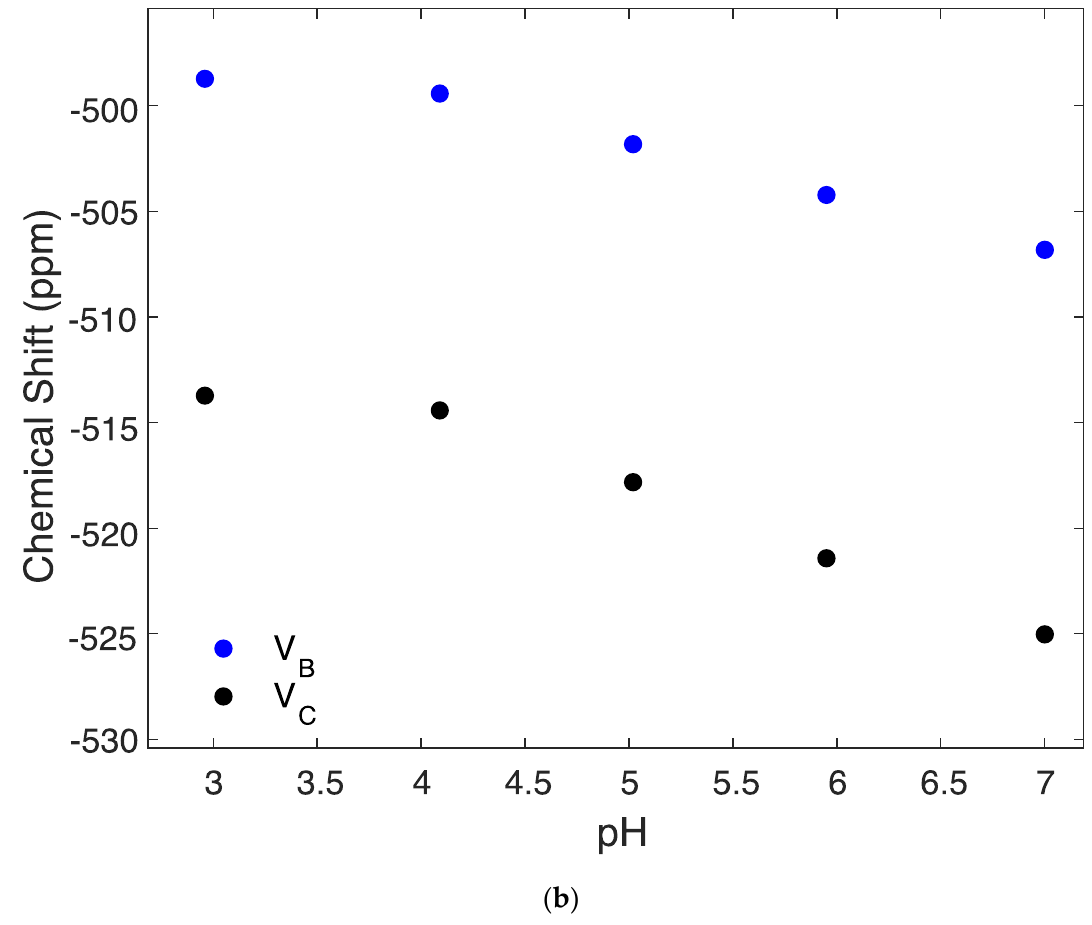
Figure 4. The 51 V NMR spectra of a solution of 5 mM vanadate (and 0.5 mM V 10 ) is shown from pH 2.96 to 7.00; assignments are V A ( − 414 ppm), V B ( − 498 ppm), and V C ( − 525 ppm) ( a ); plots of the chemical shift as a function of pH for the three different V atoms in the V 10 anion, of the two 51 V nuclei on the surface of the anion, V B ( − 498 ppm), and V C ( − 525 ppm) ( b ). See Figure 1 caption and the text for the